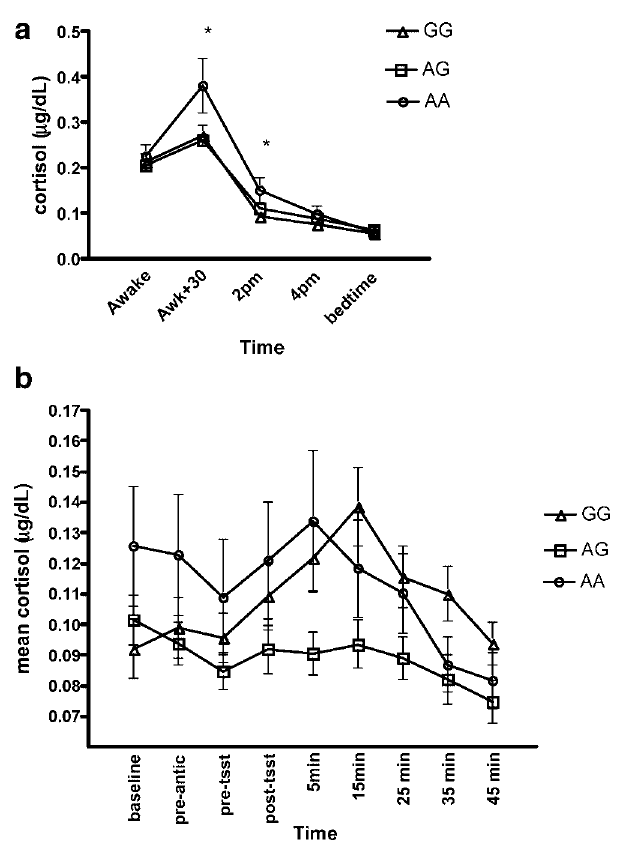
Figure 4. ( a ) Mean (SE) diurnal cortisol secretion across genotype group . ( b ) Mean (SE) stress-reactive cortisol secretion across genotype group. p = 0.001.Specifically,theGGgroupdisplayedgreaterpercentagechange ( M = 0.72, SE = 0.17) compared to the AG group ( M =− 0.10, SE = 0.04) and the AA group ( M = 0.15, SE = 0.19), ps